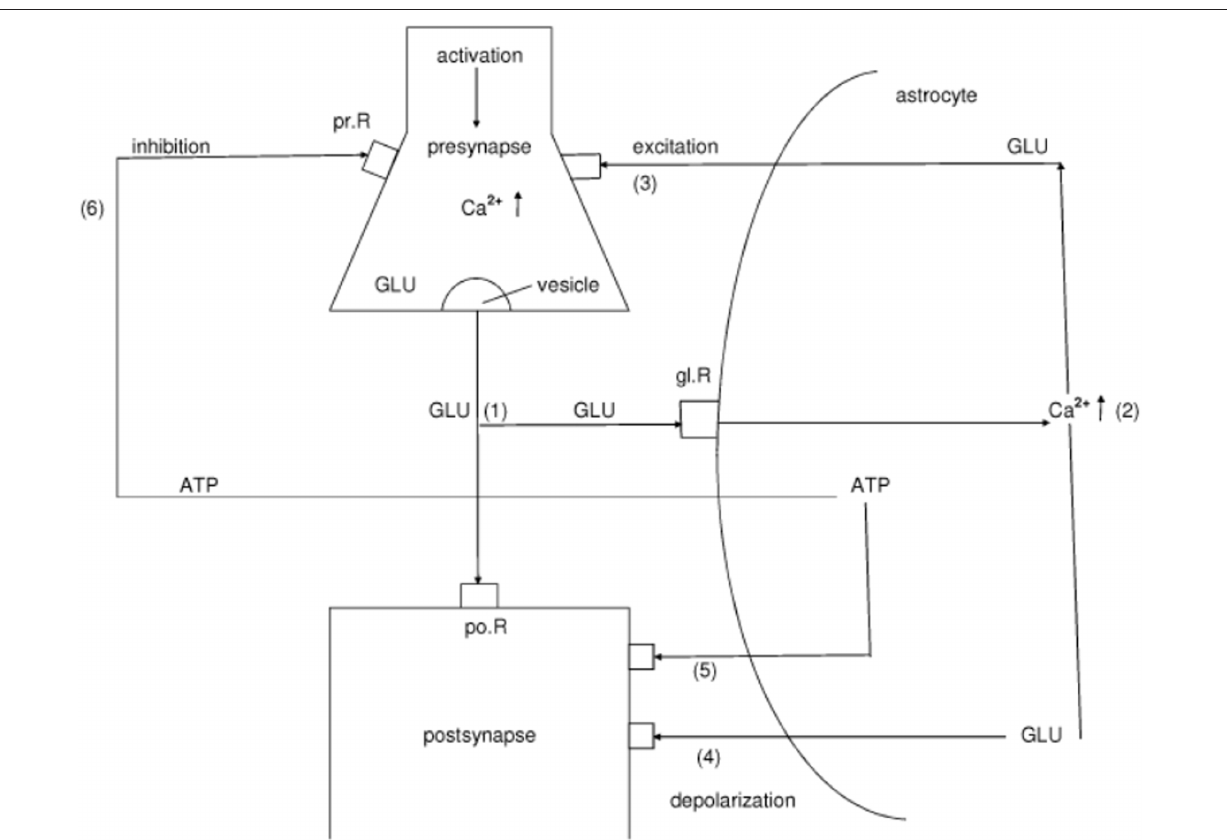
release of GLU from the astrocyte. GLU excitation of presynaptic receptors (prR) (3) modulates GLU-release, while activation of prR (4) directly depolarizes the postsynapse. Activation of the astrocyte also elicits the release of adenosine- triphosphate (ATP), which depolarizes the postsynapse (5) and inhibits the presynapse (6) via occupancy of the cognate